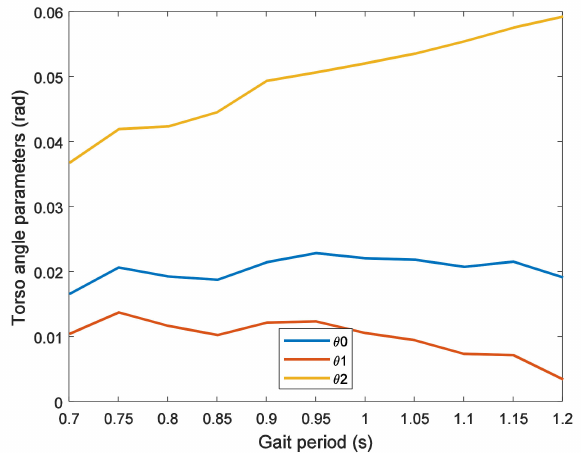
Figure 12. Torso angle parameters of torso pitch motion (TPM) with different gait periods when L = 0.3 m.